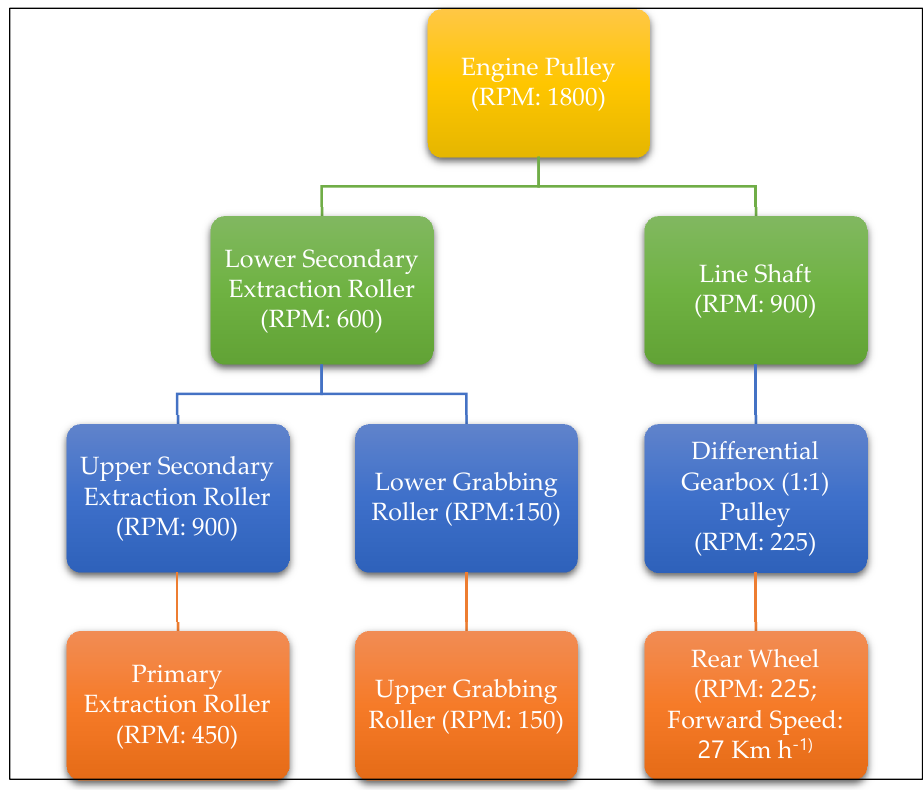
Figure 9. The power transmission system of the modified Aashkol. Spring-loaded tray: There was a spring-loaded tray (650 mm length × 205 mm diam- eter) under the primary extraction roller for adjusting or keeping jute plants of different diameters as they pass through the grabbing roller after the breakdown of jute sticks. It helps the primary roller to strike every plant for primary extraction. A schematic view of the spring-loaded tray of the Aashkol is shown in Figure 10.